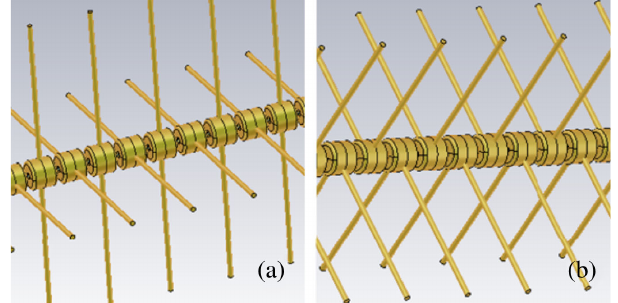
FIG. 6. Cross-configuration (a): the angle between two stems baring the same drift tube is 180 degree and at the subsequent tube the arrangement is rotated by 90 degrees. Alternating V-configuration (b): the angle between two stems baring the same tube is 90 degrees and at the subsequent tube the arrange- ment is rotated by 180 degrees. Both stem configurations have the same stem density in the cavity quadrant resulting in equal transverse admittances. The transverse admittance between tank 4. Simulated current distribution on the drift tube surface and tube can be reduced to zero or even to negative values. corresponding to the inductance L and electric gap field t corresponding to the capacitance C between tubes. The longi- t tudinal electric field nearby the tubes is merged into this capacitance as